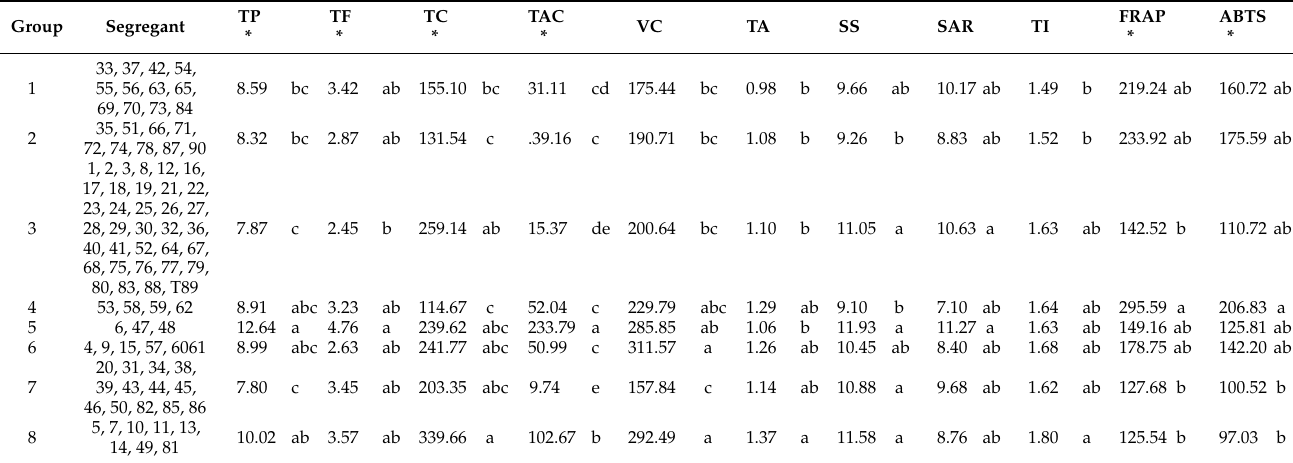
Different letters indicate significant differences between groups (LSD test, p ≤ 0.05). TP = total polyphenols (mg GAE g − 1 ); TF = total flavonoids (mg cat g − 1 ); TC = total carotenoids ( µ g β -carotene g − 1 ); TAC = total anthocyanin content (mg cy-3-glu 100 g − 1 ); VC = vitamin C (mg 100 g − 1 ); TA = titratable acidity (%); SS = soluble solids ( ◦ Brix); SAR = sugar/acidity ratio; TI = taste index; FRAP = antioxidant capacity FRAP method ( µ m Trolox g − 1 ); ABTS